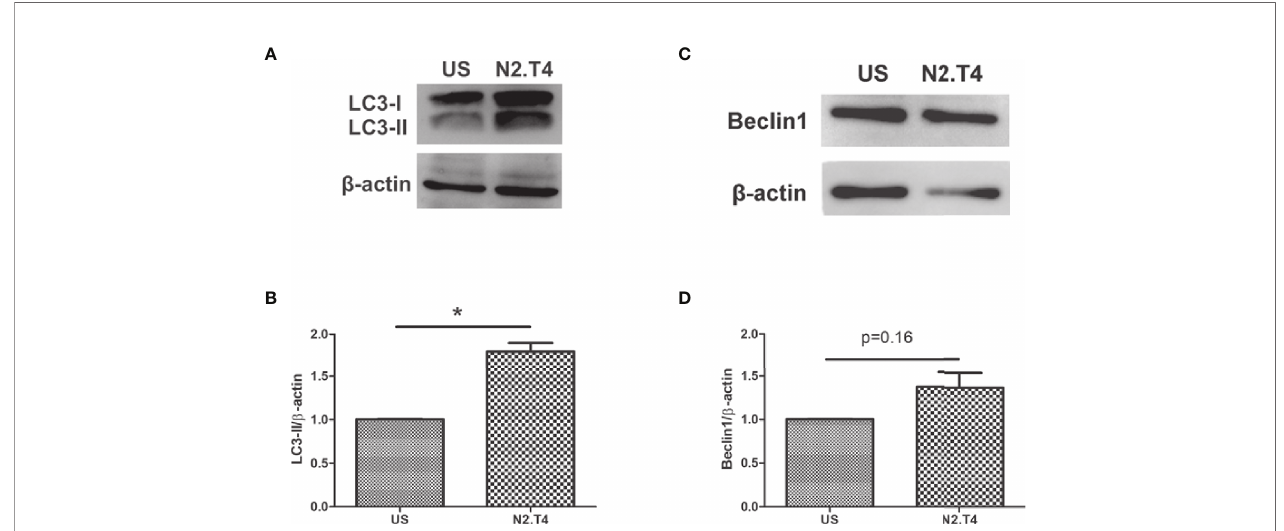
FIGURE 5 | N2.T4 signaling induced autophagy in MSC. MSC (2 X 10 6 cells/well) were stimulated with either N2.T4 or left untreated for 24h. The cells were lysed with a RIPA buffer containing a protease inhibitor cocktail. The samples were subjected to SDS-PAGE and Western blotting. The blots were probed with antibodies against autophagy markers LC3 andbeclin-1 (A,C) . The densitometric analysis of LC3 and beclin-1, normalized with b -actinis representedin graphs (B, D) , respectively. The data shown are representative of three independent experiments. The insetrepresents p value. *p <